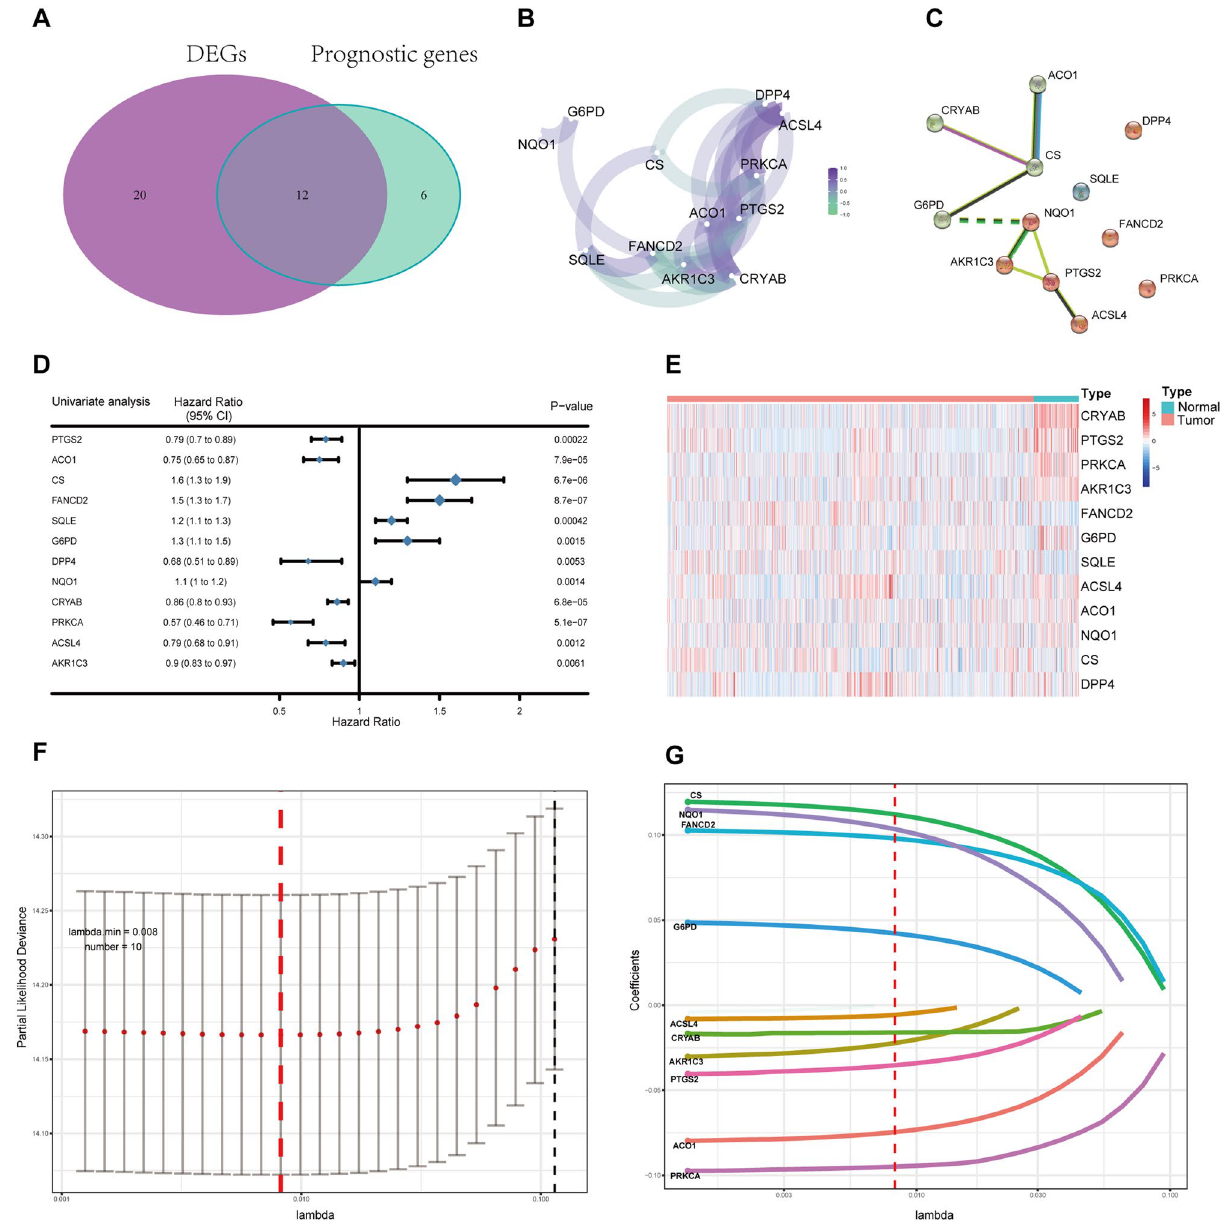
Figure 2. Identification of candidate genes associated with ferroptosis in the METABRIC cohort. ( A ) Venn diagram to identify differentially expressed genes associated with OS between tumor tissue and adjacent normal tissue. ( B ) The correlation network of candidate genes. Correlation coefficients are shown in different colors. ( C ) The PPI network downloaded from the STRING database shows the interactions between candidate genes. ( D ) The forest plot displays the results of the univariate Cox regression analysis of the relationship between the gene expression of candidate genes and OS. ( E ) Heatmap showing differences in the expression of candidate genes between tumor tissue and adjacent normal tissue. ( F ) The partial likelihood deviation curve was plotted versus lambda. Dotted vertical lines were drawn at the optimal values by using the minimum criteria and the 1 standard error of the minimum criteria (the 1-SE criteria). ( G ) The optimal lambda resulted in 10 nonzero (Fig. 6H). Interestingly, several T-cell subsets, including Th2, Th17, Tgd, Tfh, Tem, Tcm and Tc, were signifi- cantly different between the two groups in TCGA cohorts (adjusted P < 0.05) (Table S7). Chemotherapy response and chemotherapeutic agent prediction based on the gene signa‑ ture in high‑ and low‑risk patients with luminal subtype BRCA . Chemotherapeutic agents with higher drug sensitivity are urgently needed for these patients, so two chemotherapy response datasets (CTRP2.0 and PRISM) were analyzed. CTRP2.0 contains sensitivity data for 481 compounds over 835 CCLs, and PRISM